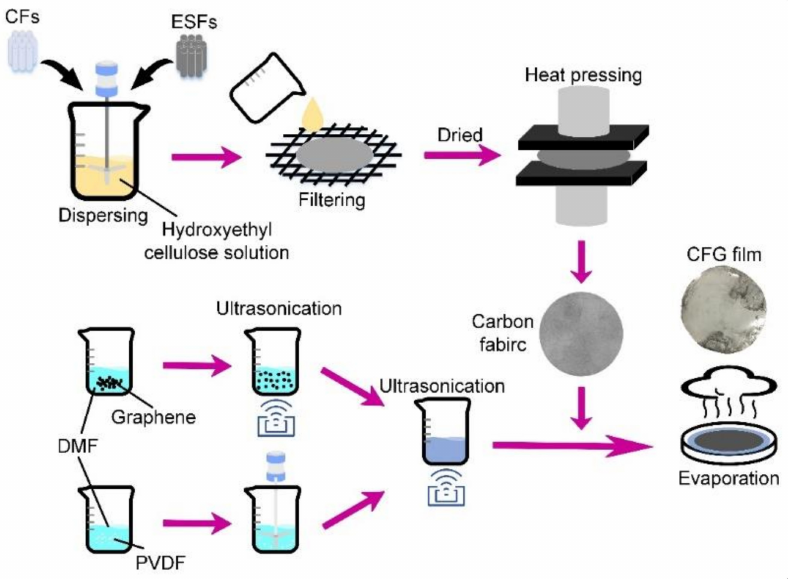
Figure 1. Schematic diagram of the preparation process of a CFG